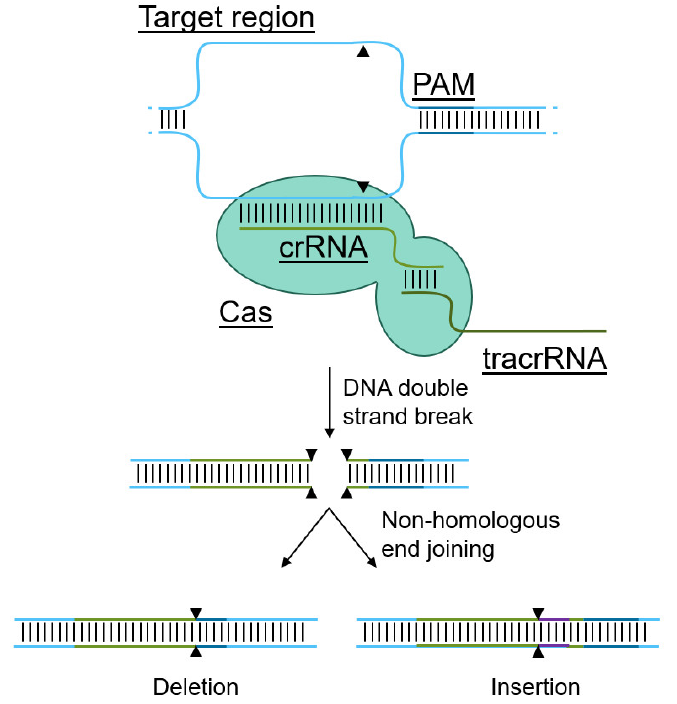
Figure 2. Mechanism of CRISPR-mediated genome editing and delivery methods. Cas proteins utilize a targeting crRNA to recognize the target site in the genome, but requires a trans-activating tracrRNA to induce a double strand break. The resulting double strand break is repaired via non-homologous end joining, resulting in deletions and insertions, effectively rendering genes non-functional. Table 1. Different CRISPR-methods and their